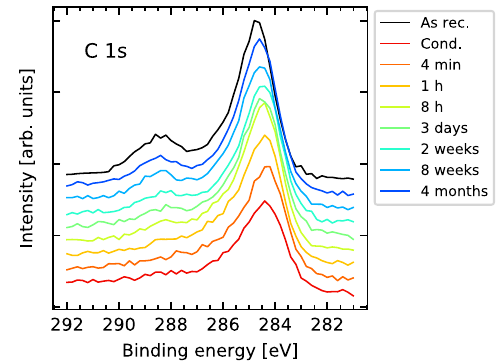
FIG. 5. C 1s lines of an OFE copper sample in its as received and conditioned states and after different storage times in a